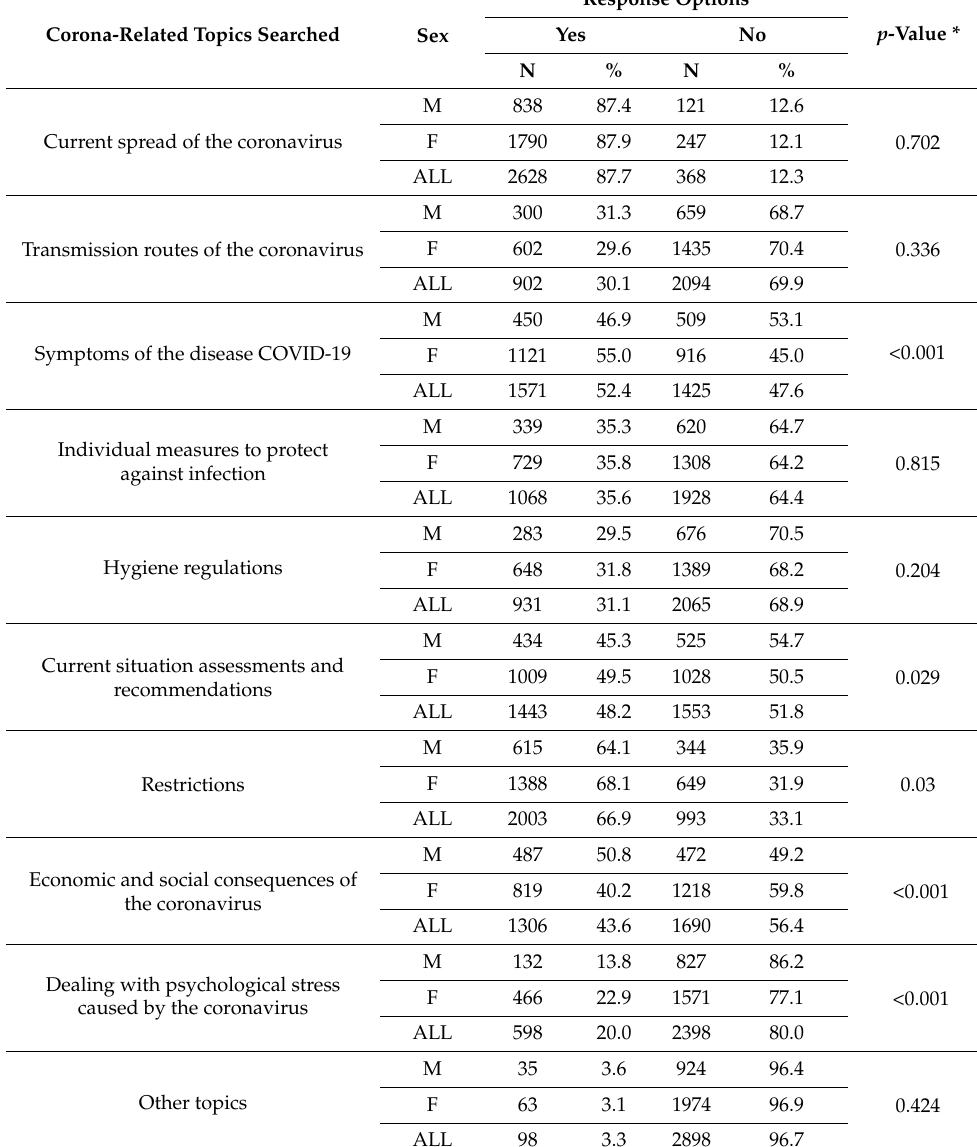
Table 2. Descriptive analysis of the corona-related topics searched ( N =